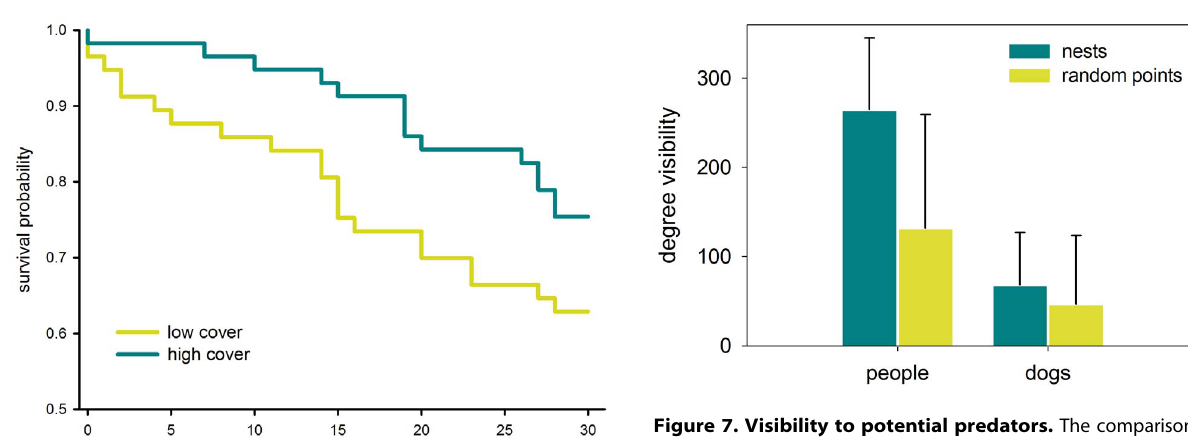
Figure 7. Visibility to potential predators. The comparison of the average visibility towards humans and dog-sized predators from real nest and a set of control points are shown. Error bars indicate the standard